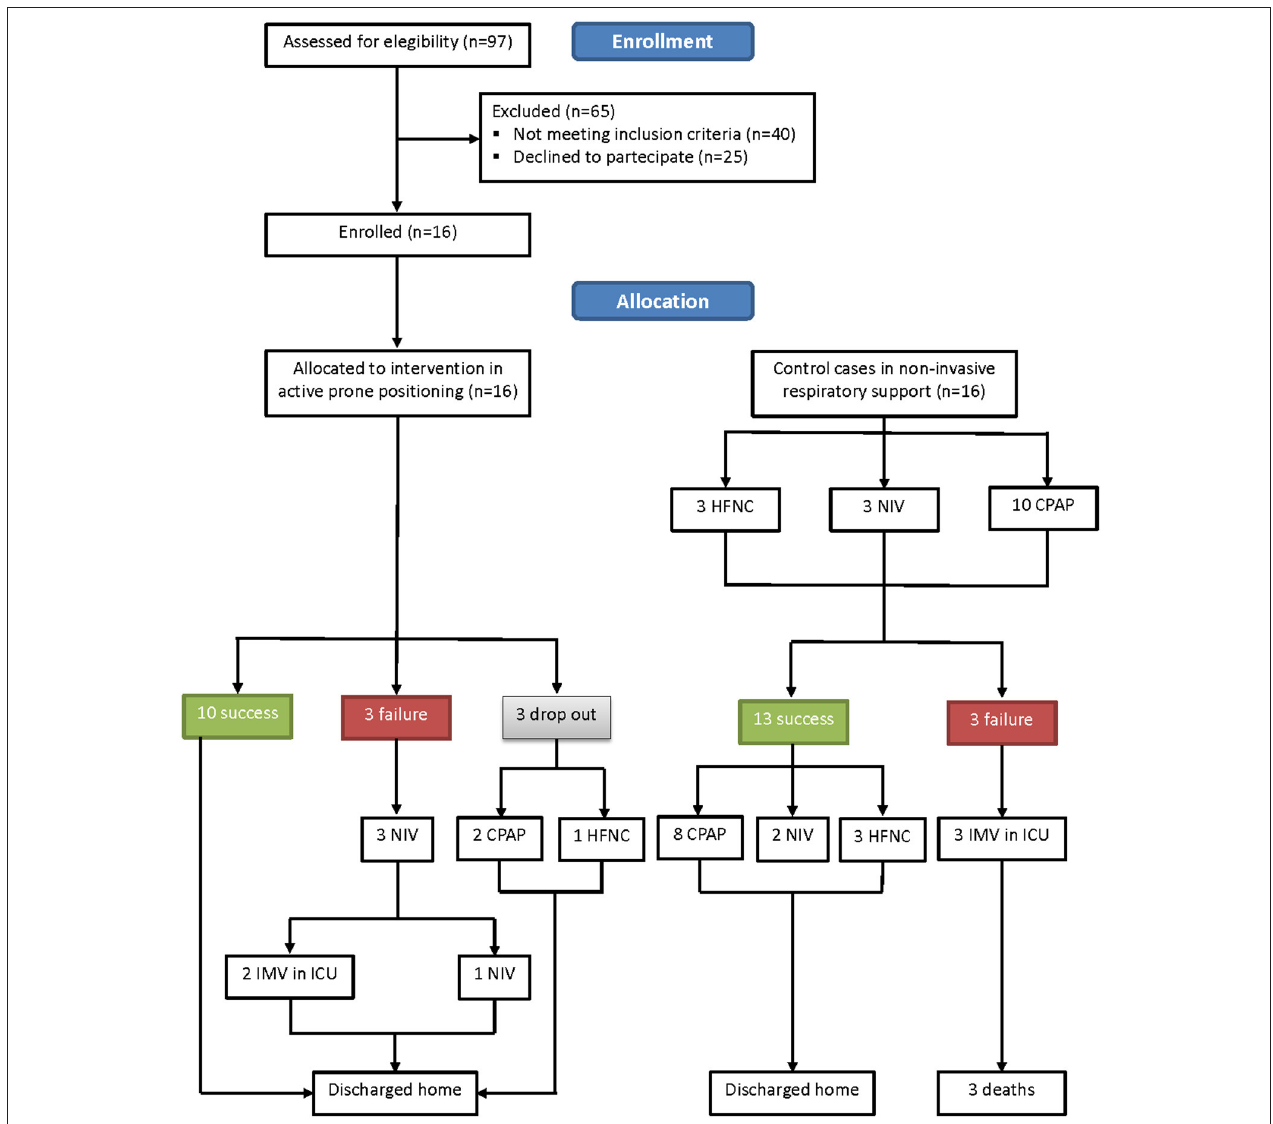
FIGURE 2 | Study flow